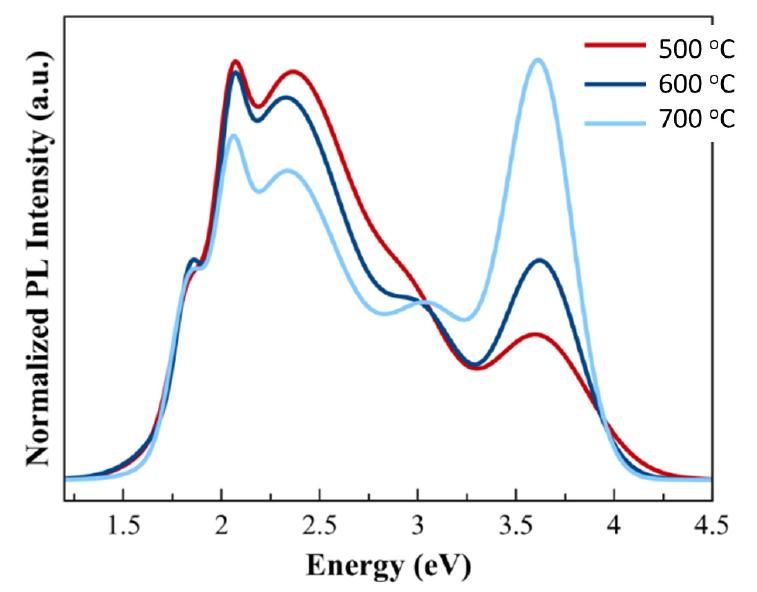
Figure 6. PL spectra at room temperature of GaN grown at various growth temperatures.